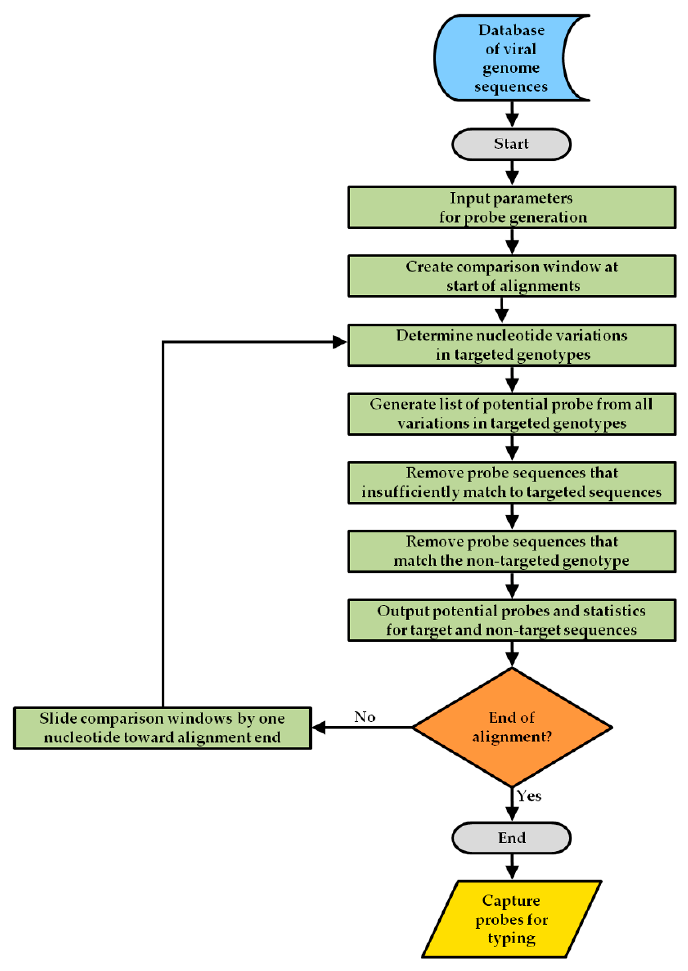
Figure 2. Steps of the VGM algorithm for the design of capture probes, detecting distinct genotypes of NoV or HAV.